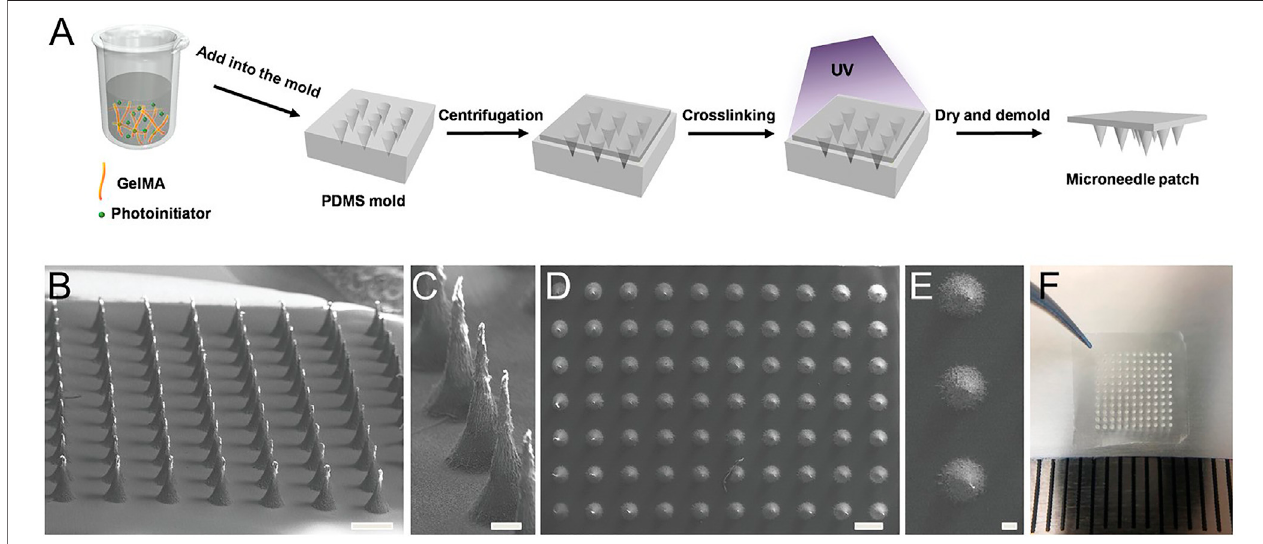
FIGURE2| Preparation oftheGelMAMNpatch. (A) SchematicoftheMNpreparation process. GelMAaqueous solution(aq) waspouredintoaPDMSmold. After centrifugation and UV cross-linking, the patch was dried and demolded. (B,C) SEM images show the side view of the GelMA MN array and (D,E) SEM images from the topview.Alignedconicalneedleswereformedwithanapproximateheightof600 µmandabottomdiameterof300 µm.Scalebar:500 µmin (B) and (D) and100 µmin (C) and (E) . (F) Picture of the GelMA MN patch containing an 11 × 11 array of MNs over a 1 cm × 1 cm area. Reproduced with permission (Zhu et al., 2020). Copyright 2020,